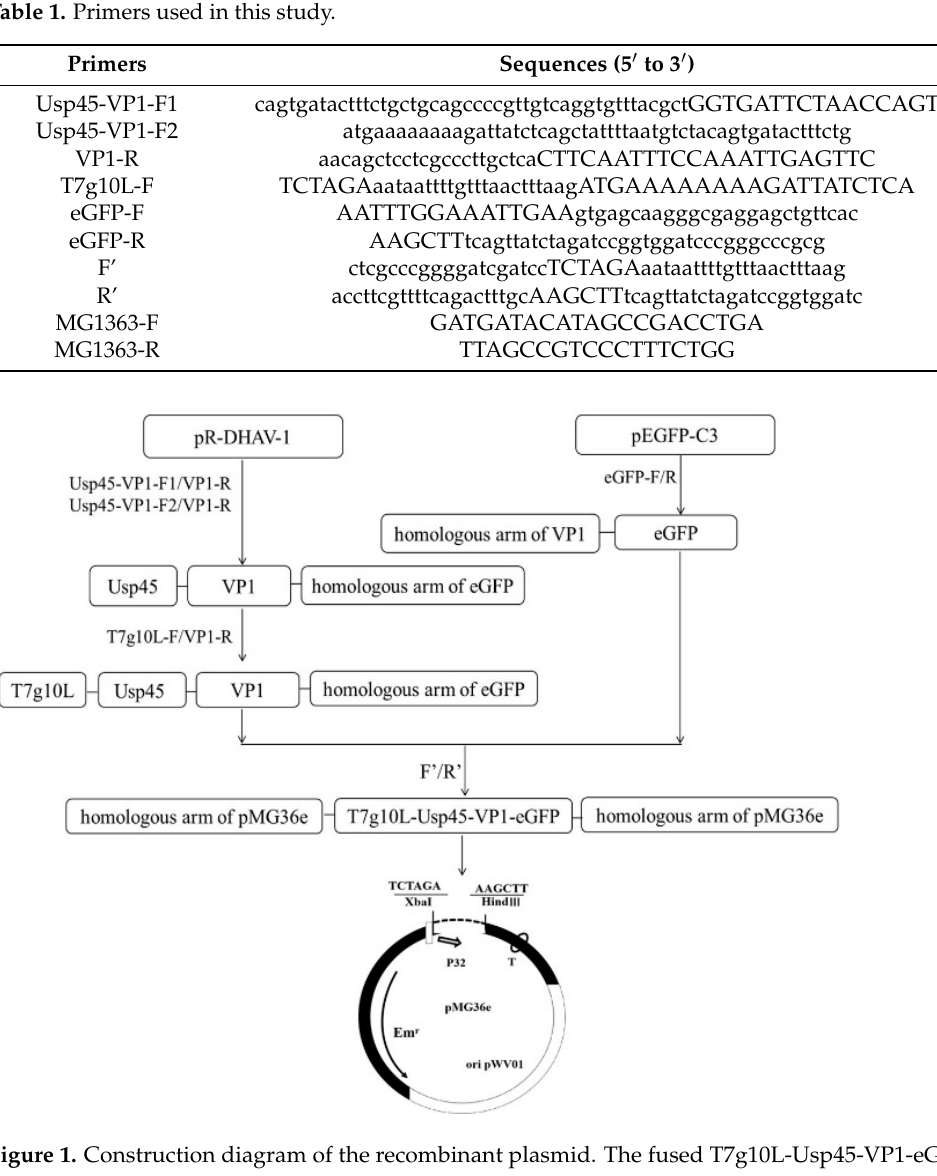
Table 1. Primers used in this study.